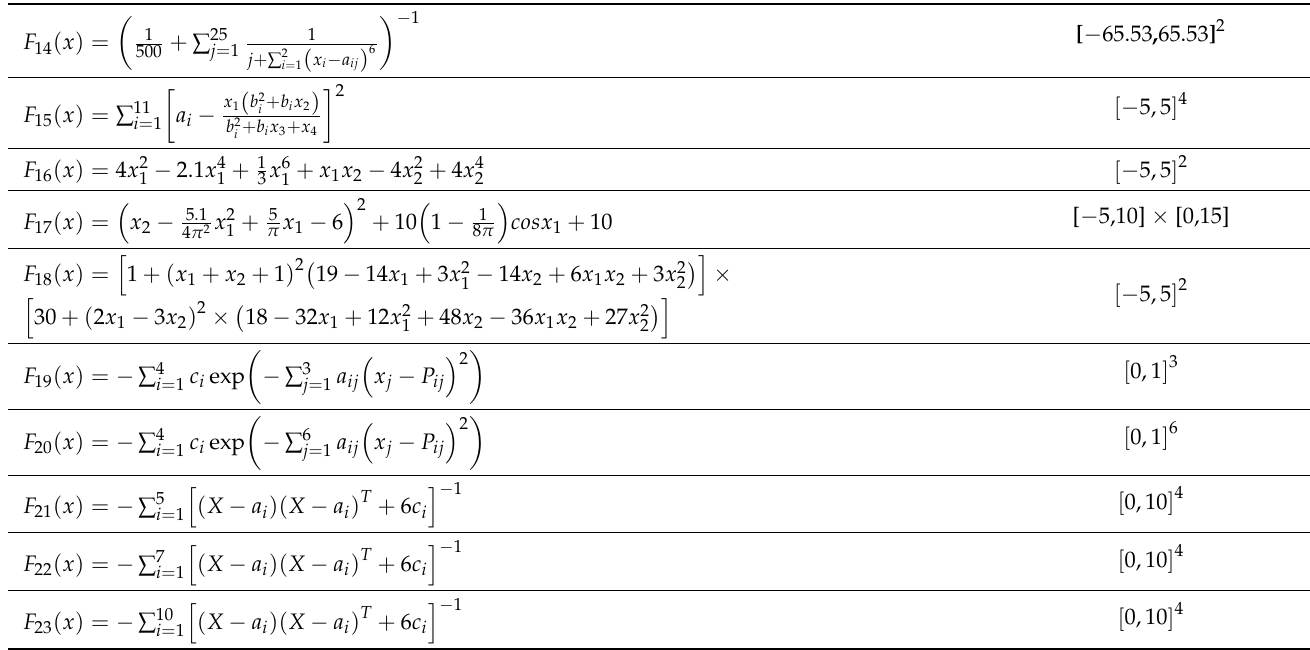
Table A3. Multimodal test functions with fixed